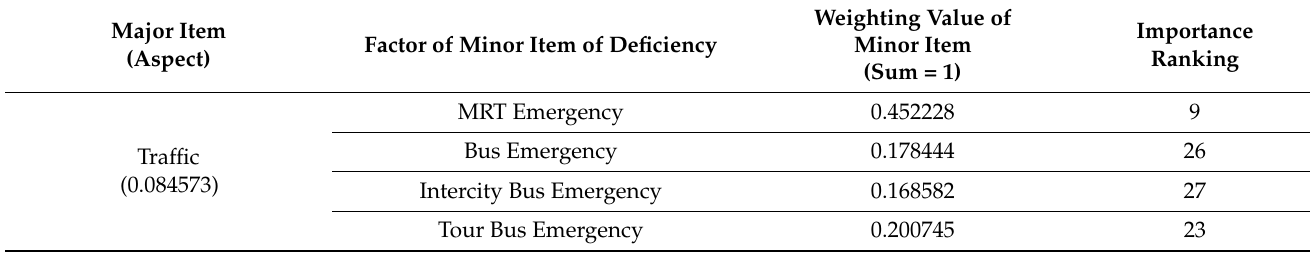
Table 4. Weighting values for the effects of